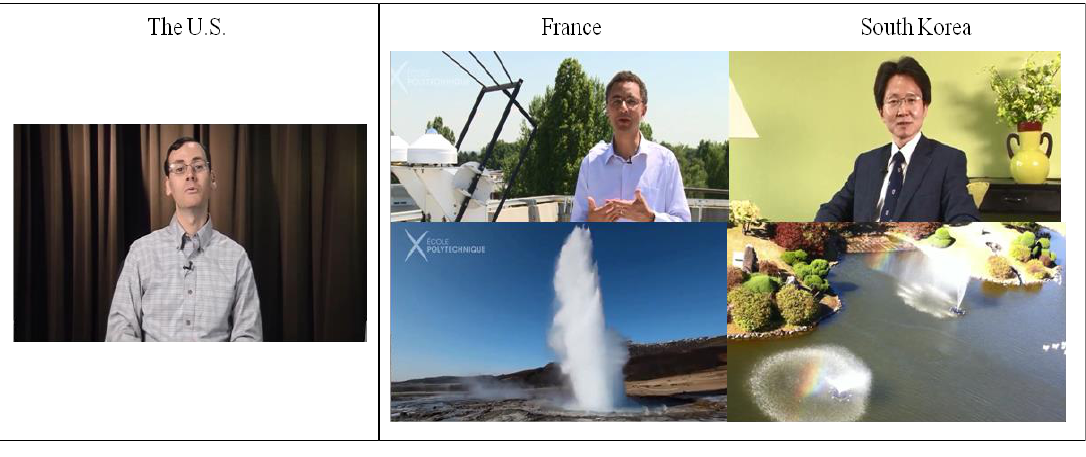
Figure 3. Examples of masculinity and